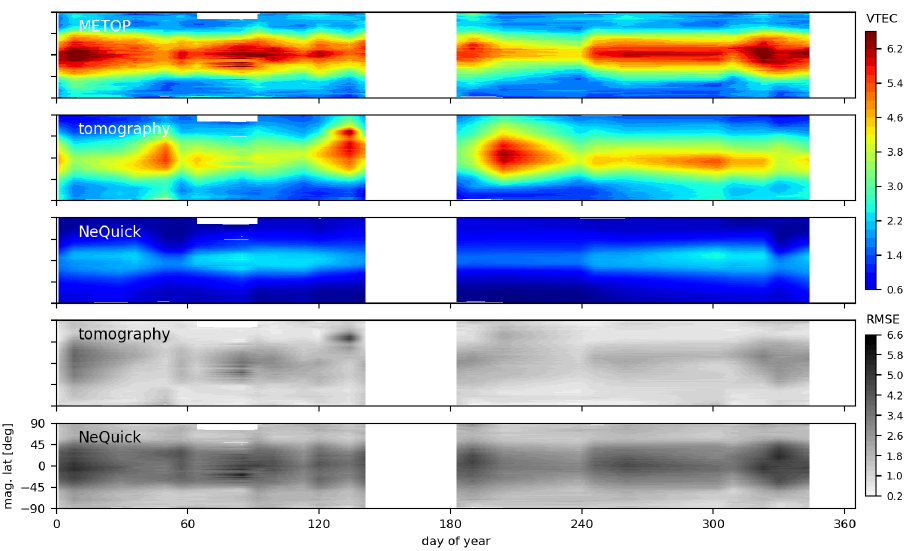
Figure 16. VTEC and RMSE distributions during 2018 estimated with METOP, NeQuick and tomog- raphy. VTEC values were taken as a daily average in terms of magnetic latitude. White spaces refer to the lack of METOP or COSMIC data. Units are given in 10 16 el/m 2